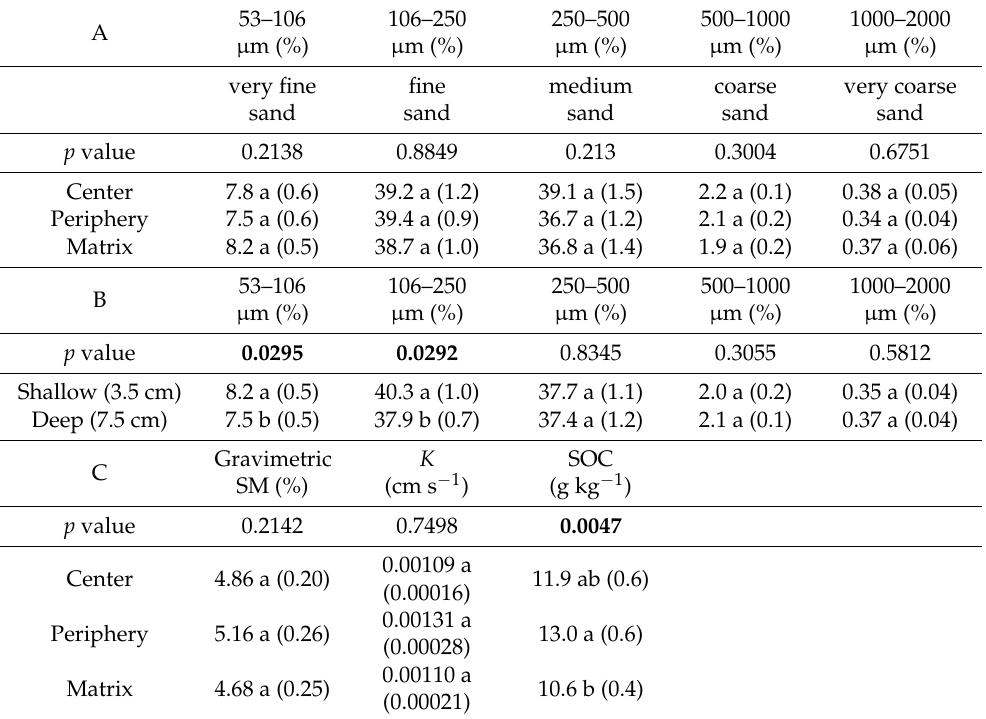
Table 1. (A) Microenvironment effect on the soil texture; (B) Depth effect on the soil texture; (C) Microenvironment effect on the soil gravimetric moisture content (SM), hydraulic conductivity ( K ), and organic carbon content